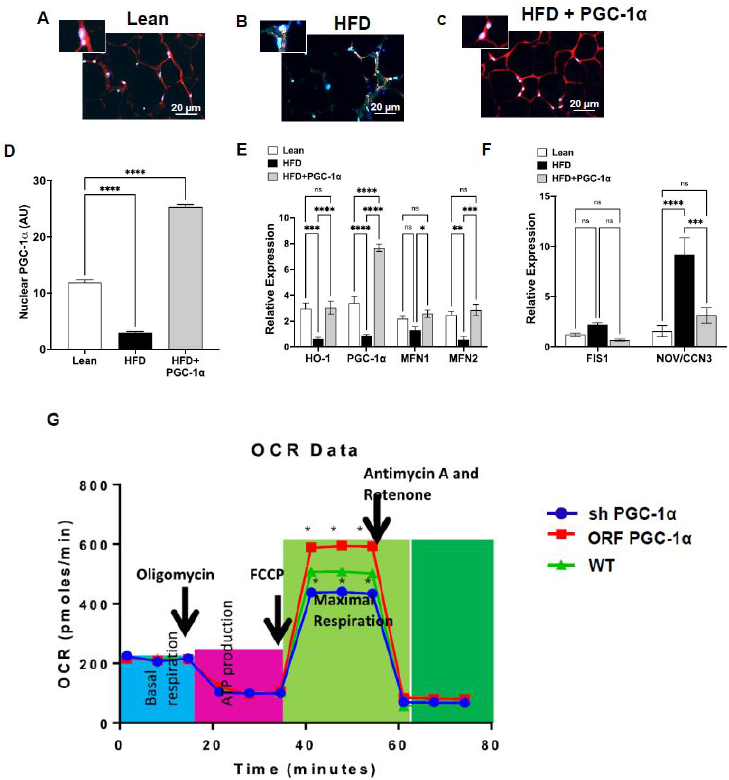
Figure 3. Effects of the adipocyte-specific overexpression of PGC-1 α in high-fat-diet (H.F.D.)-fed mice compared to lean and untreated HFD mice. Iimmunofluorescence photomicrographs of PGC-1 α expression (red staining) at the adipose tissue level of ( A ) lean, ( B ) H.F.D., and ( C ) HFD + PGC-1 α mice. Graph ( D ) summarizes the immune morphometrical measurement of the nuclear localization of PGC-1 α (A.U.). Quantitative gene expression analysis of ( E ) PGC-1 α , HO-1, Mfn1, and Mfn2; ( F ) Fis1 and NOV/CCN3 in adipose tissue of Transgenic-adipo-PGC- 1α mice fed with a high-fat diet. Data are expressed as mean ± S.E.M. (n = 5); **** p < 0.05 versus lean; *** p < 0.05 versus HFD,* p < 0.05 versus HFD. ** p < 0.05 versus lean ( G ) Oxygen consumption rates (OCR) in PGC- 1α knockdown (shPGC1α), overexpression (ORF PGC - 1α), and control cultured adipocytes, n = 3. **** p < 0.005, versus control. The maximal respiration capacity represents the sum of all physiological mitochondrial oxygen consumption.